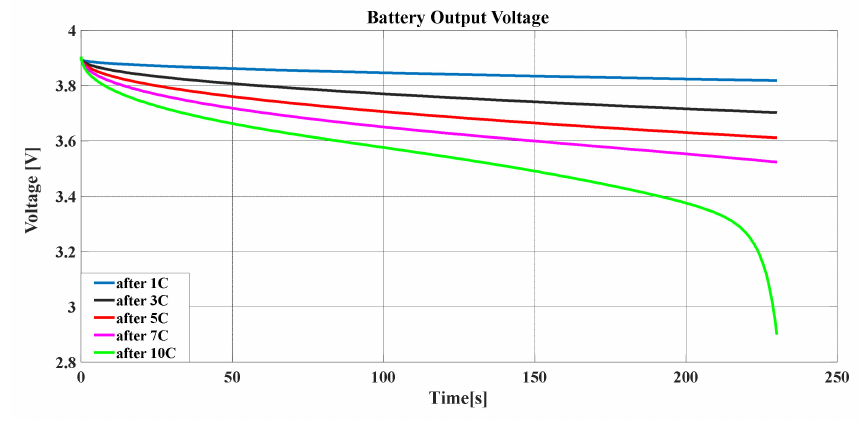
Figure 14. The battery output voltage vs. the discharging rates based on the SPM.